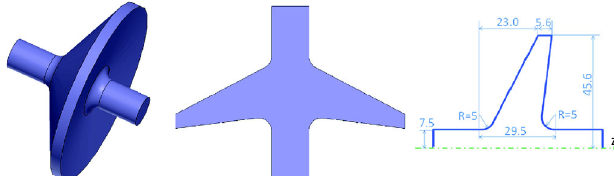
FIG. 6. (Color) Profiles and outline drawing for a modified pill- box cavity with harmonically related eigenmodes for its first three axisymmetric TM modes. Dimensions are in